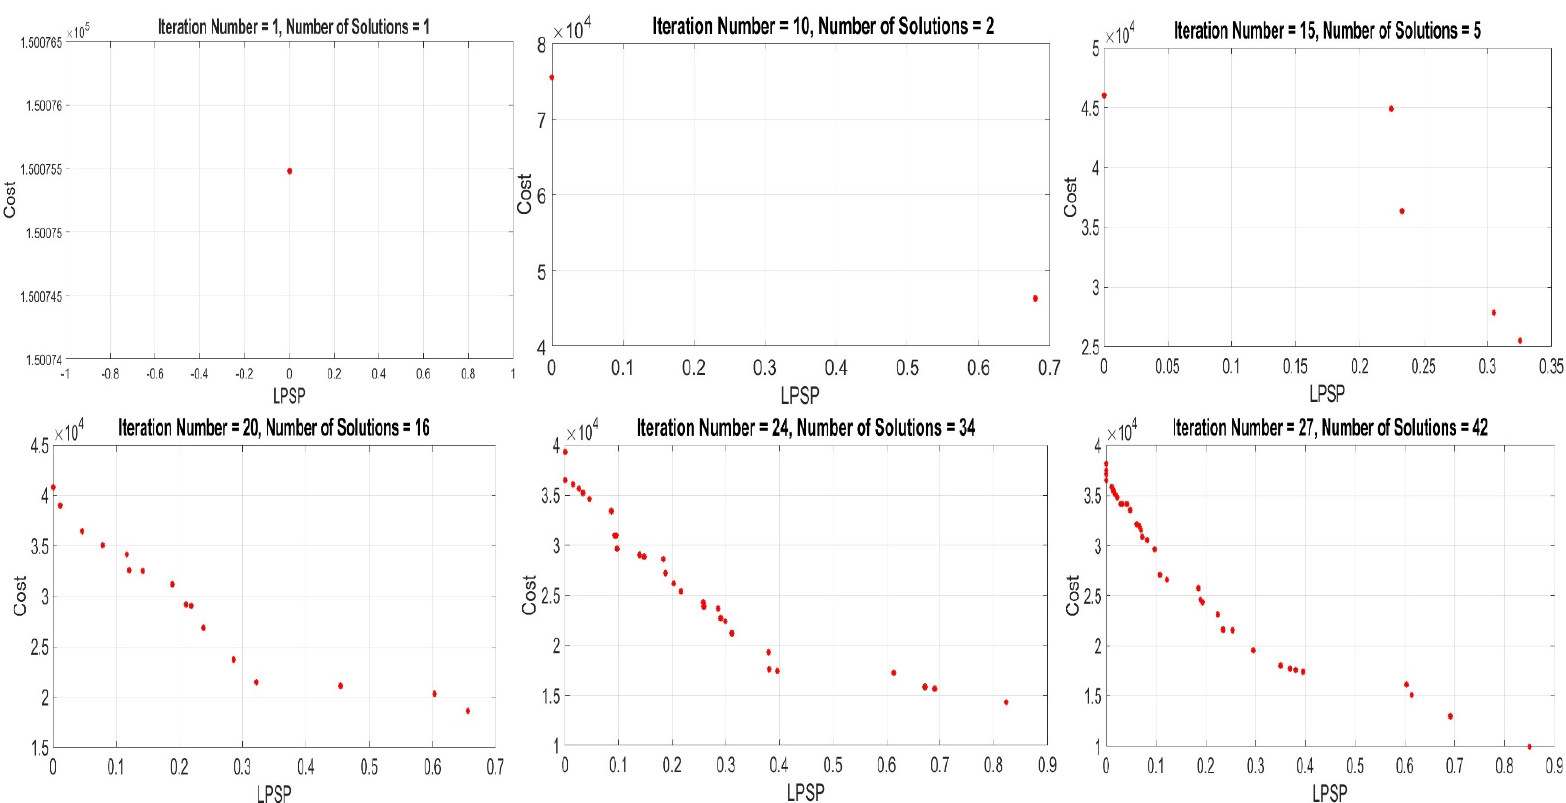
Figure 5. Gradual convergence of the solutions in the NSGA-GWO algorithm.